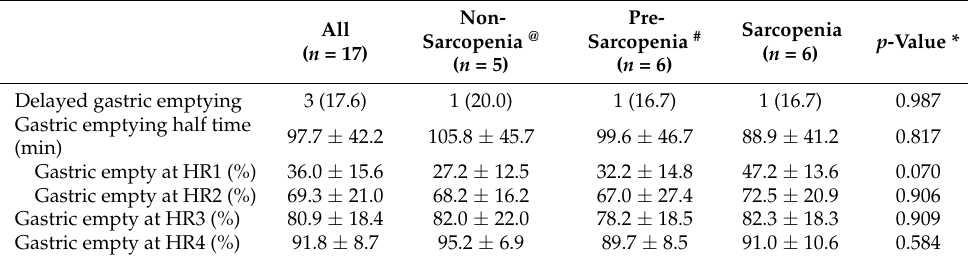
Table 2. Results of gastric emptying scintigraphy.